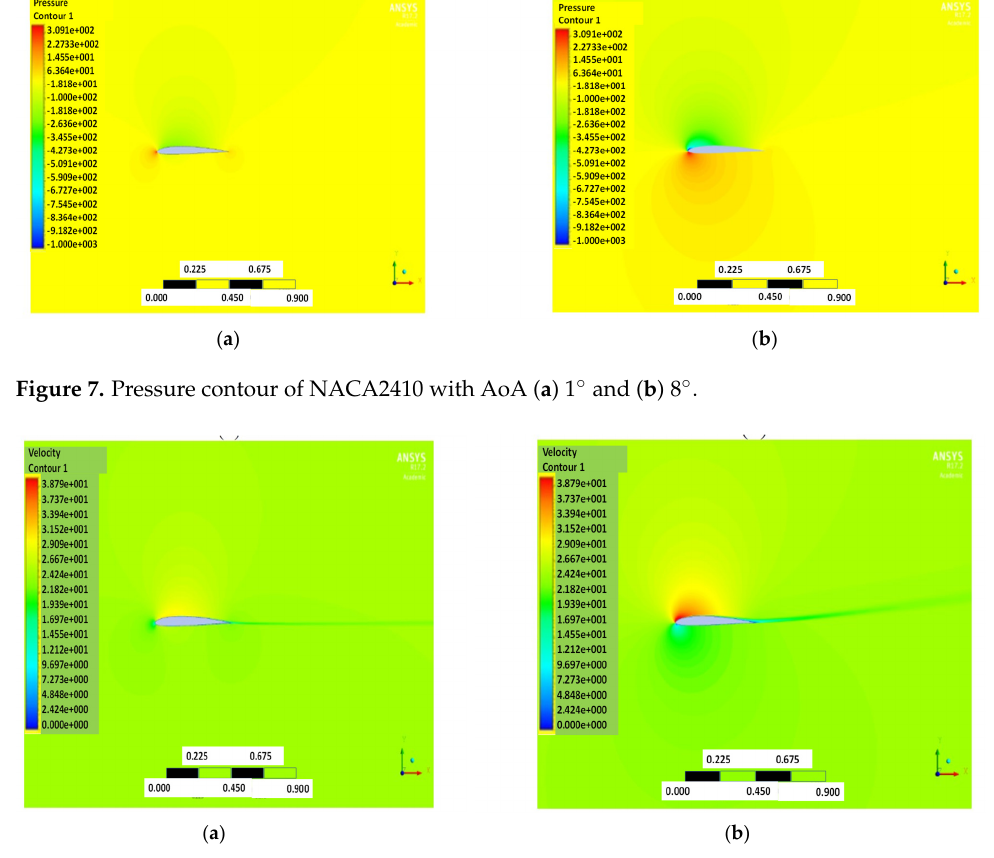
Figure 8. Velocity contour of NACA2410 with AoA 1° and 8°.